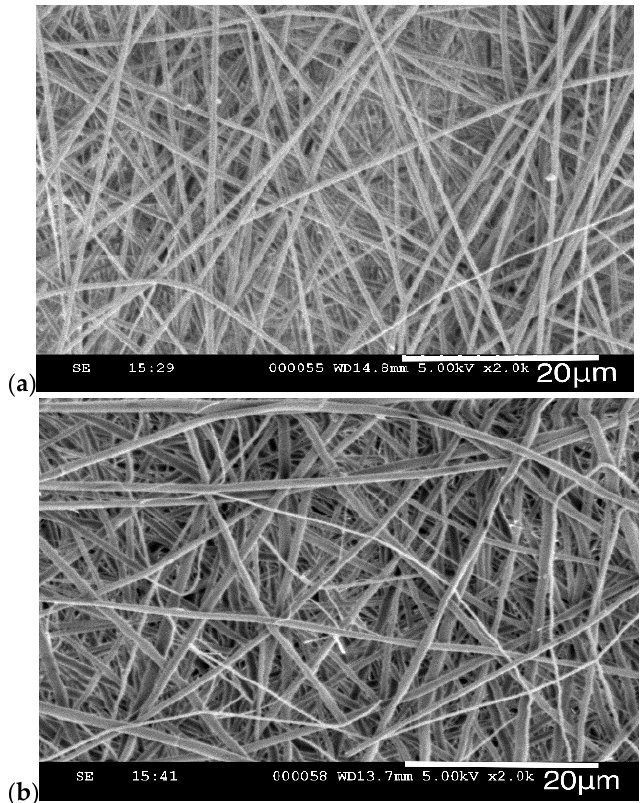
Figure 3. SEM of ( a ) lignin Stabilized and ( b ) lignin/PAMAM stabilized.